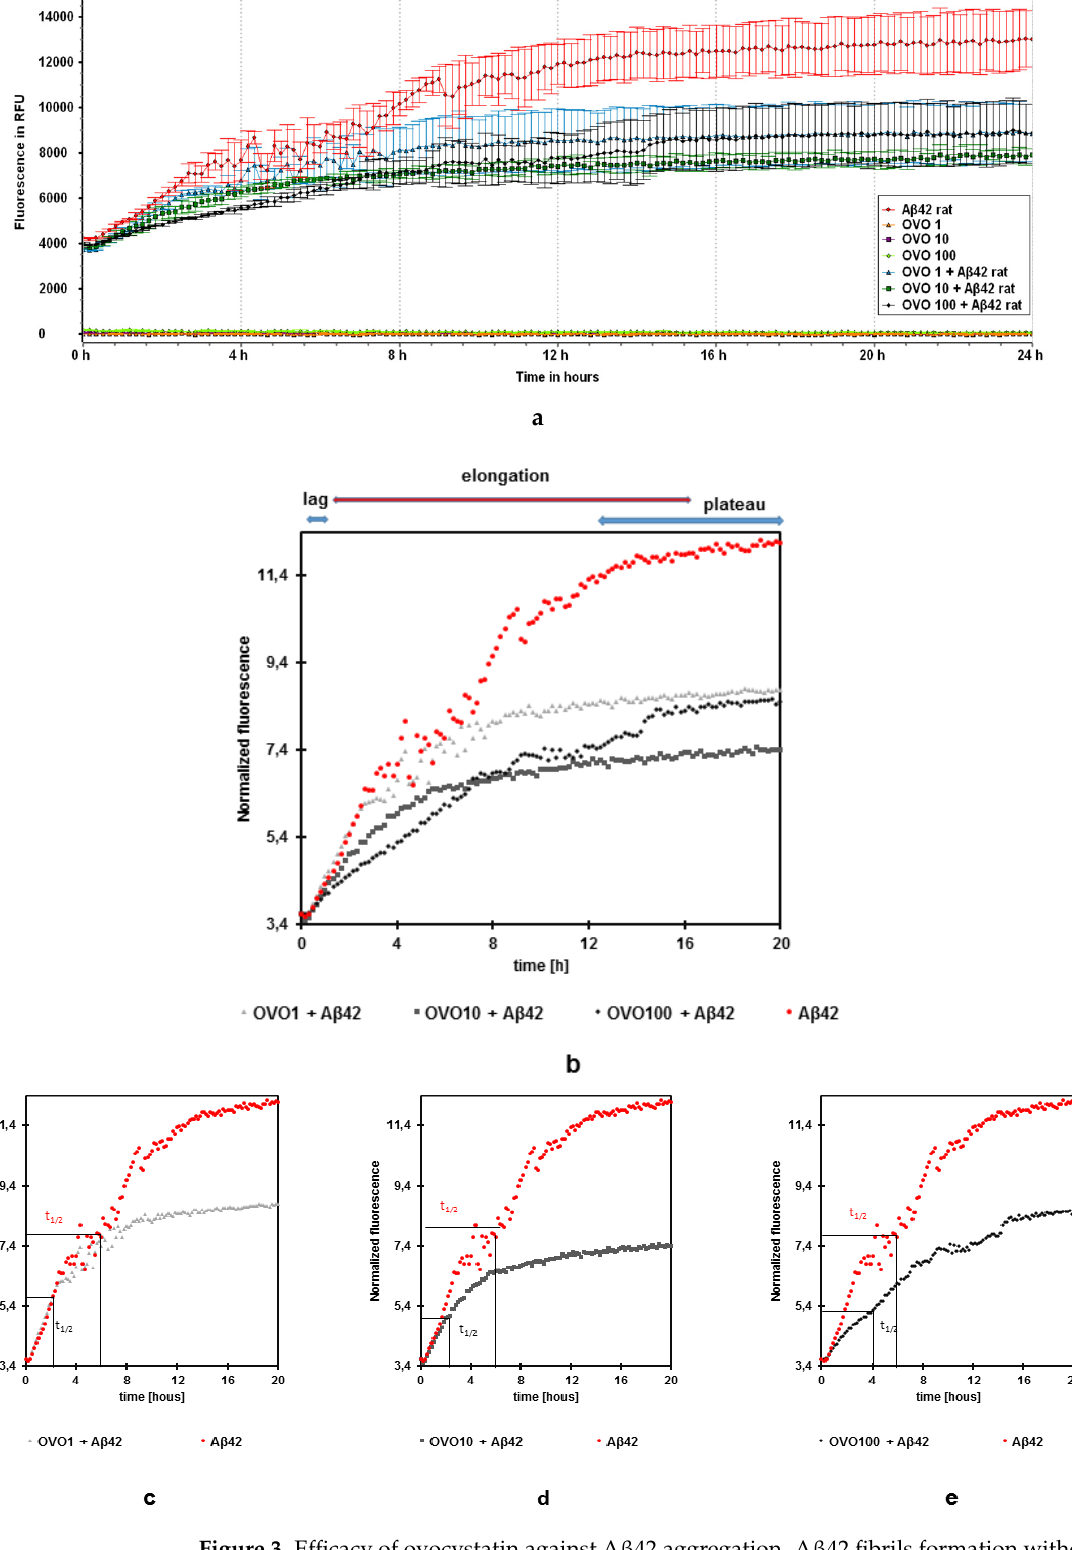
Figure 3. Efficacy of ovocystatin against A β 42 aggregation. A β 42 fibrils formation without or with ovocystatin (ovo) was monitored using ThT fluorescence assay. Fluorescence intensity was measured at an excitation wavelength of 420 nm and an emission wavelength of 480 nm ( a ). Normalized fluorescence curves with lag, elongation, and plateau phases ( b ), and half time of aggregation of A β 42 (20 µ M) alone, ( c ) A β 42 with ovo 1 µ g/mL, ( d ) A β 42 with ovo 10 µ g/mL, and ( e ) A β 42 with ovo 100 µg/mL.